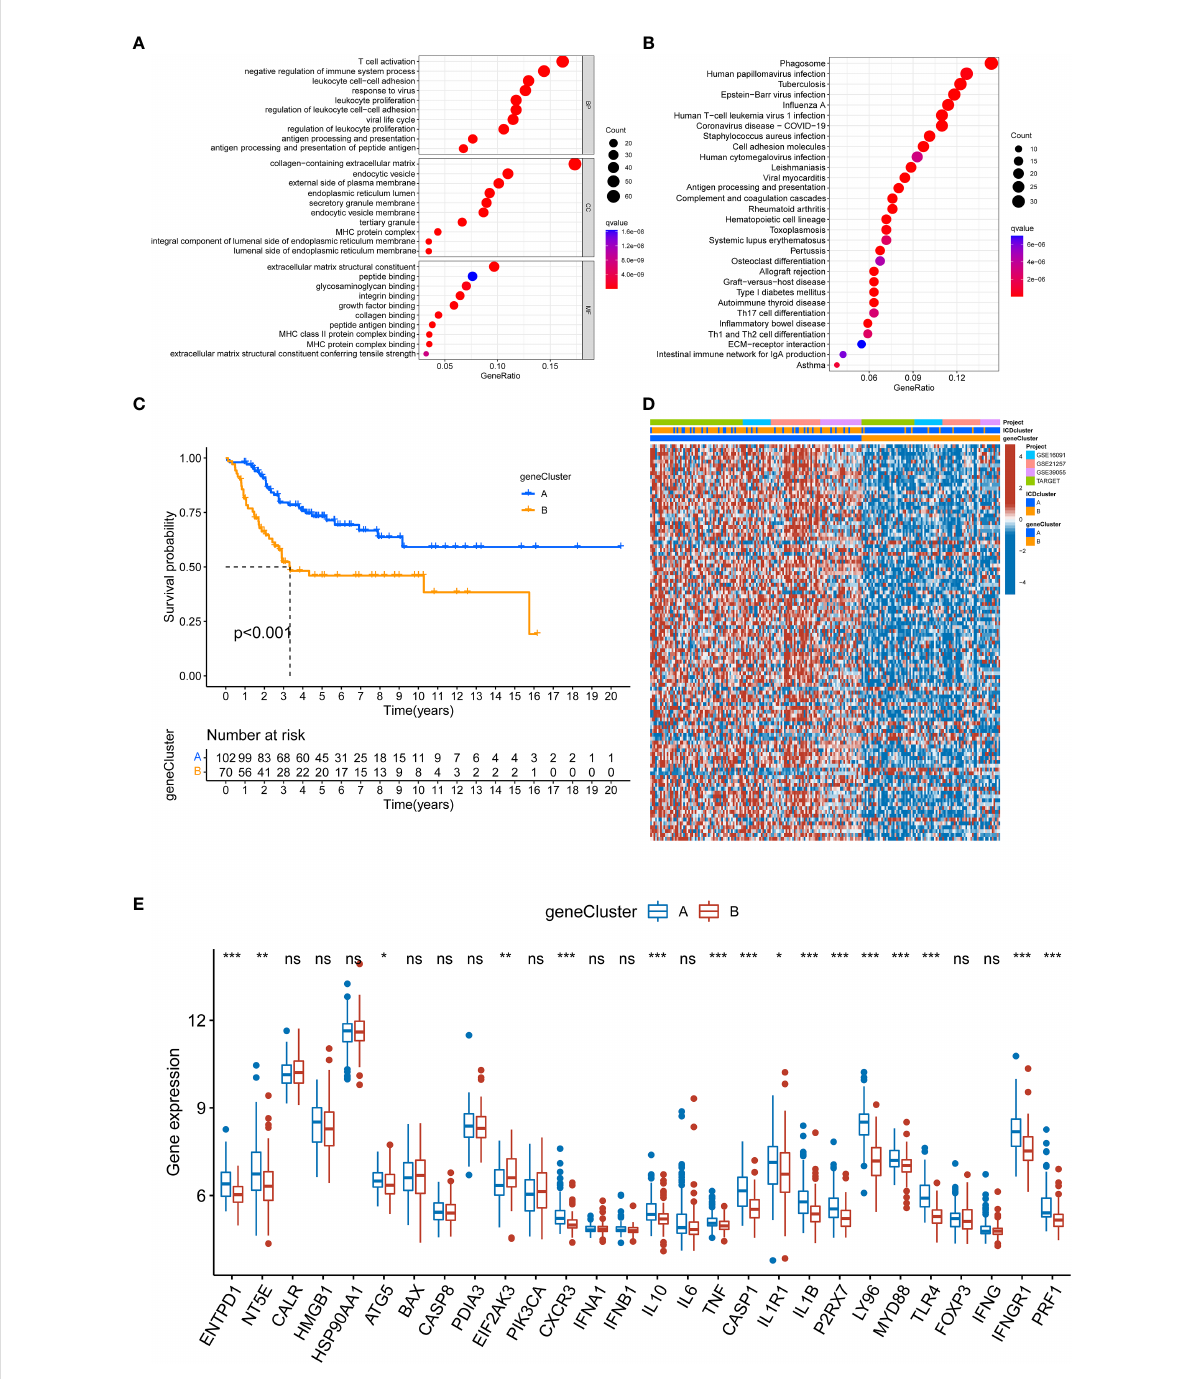
FIGURE 4 Establishment of gene classi fi cation based on ICD subtype-related DEGs. (A, B) GO and KEGG enrichment analyses based on DEGs between distinct ICD-related subtypes. (C) K-M Survival analysis of two different gene clusters in the OS cohort. (D) The relationships between the two gene cluster and ICD-related subtypes. (E) The expression level of ICD-related genes in two gene clusters. ICD, Immunogenic cell death; GO, Gene Ontology; KEGG, Kyoto Encyclopedia of Genes and Genomes; DEGs, Differentially expressed genes; K-M, Kaplan-Meier. ns, no signi fi cance, *p < 0.05, **p < 0.01, ***p <